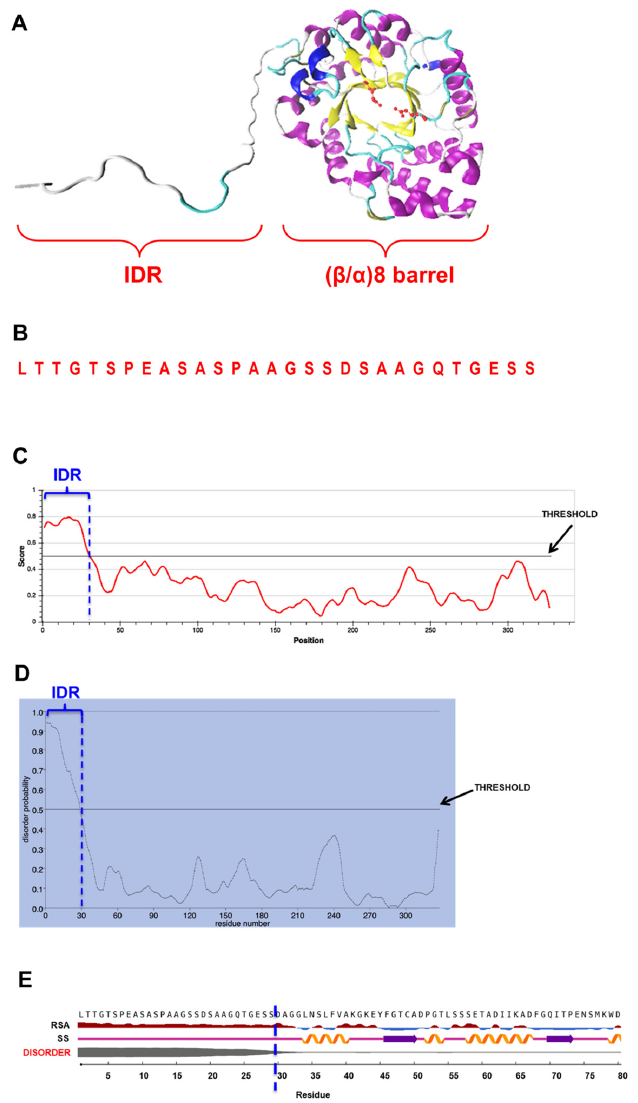
Figure 1. ( A ) Homology model of XynA, indicating the IDR and the ( β / α ) 8 -barrel fold; ( B ) Amino acid sequence of the IDR. ( C – E ) Outputs of the result of prediction of disordered regions in mature XynA by IUPred3 ( C ), PrDOS ( D ) and NetSurfP-2.0 ( E ). In all cases, the IDR of 29 amino acids appears delimited by a vertical dashed blue line. In ( C , D ), thresholds used to determine the disordered property by the respective programs are indicated. In ( E ), disorder property is indicated by a gray line, thicker line means higher disorder. Secondary structure (SS) predicted for IDR is coil structure (light violet line), while relative surface accessibility (RSA) predicts that this region is exposed (dark red).